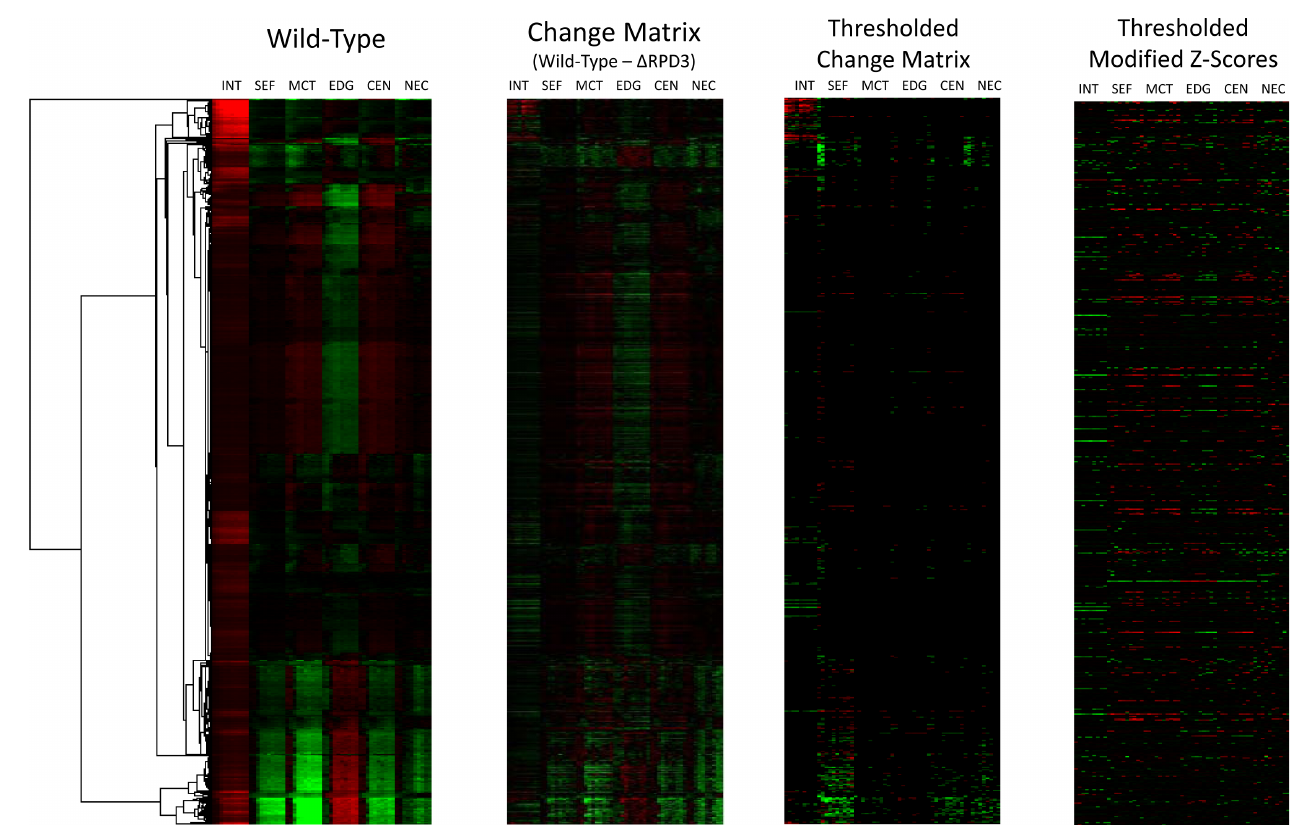
Fig 1. Heat map visualizations of the na ï ve method versus our k NN method. Clustered wild-type gene features, the change matrix, the thresholded change matrix, the na ï ve method (features thresholded using a cut-off of absolute feature > 12.0), and the thresholded modified z- scores from the k NN method (features thresholded using a cut-off of absolute feature > 2.0) are shown from left to right. Information on the heat map visualization can be found in the “ Visualization of Results ” section in the